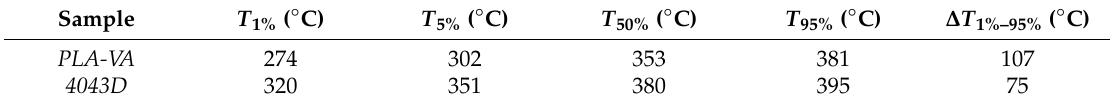
Table 5. TGA weight losses of PLA-VA and